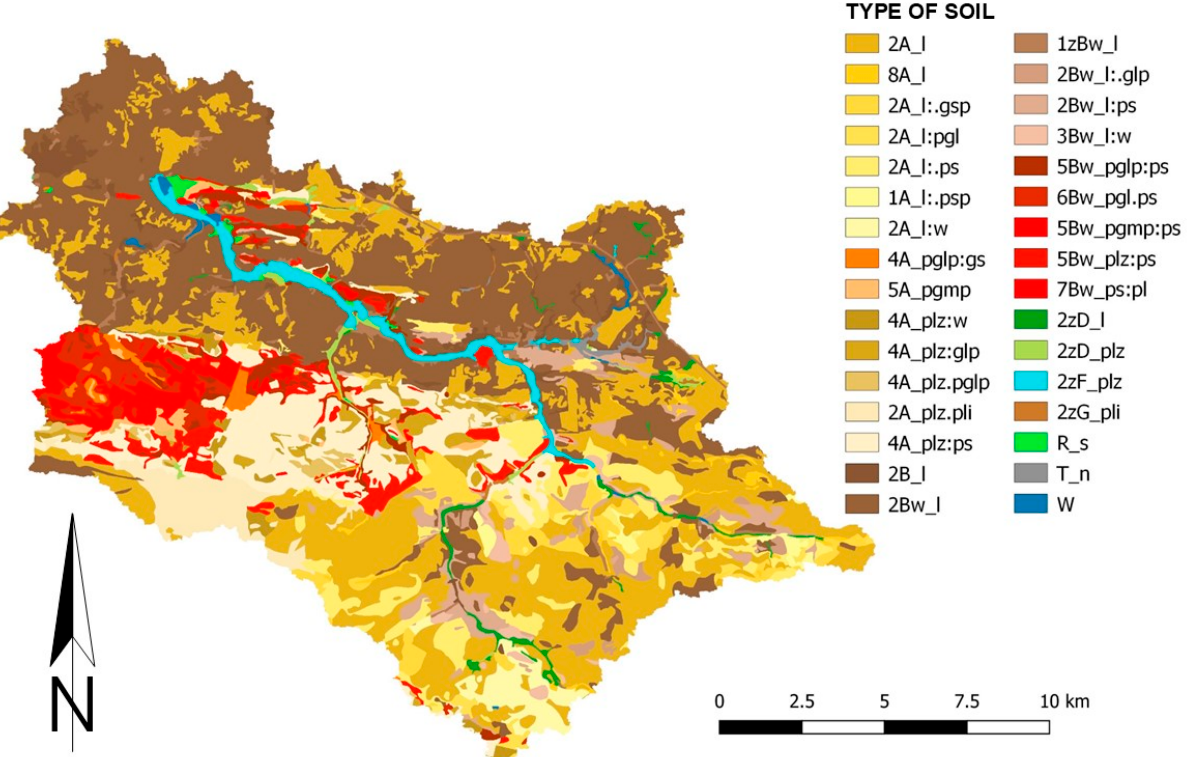
Figure 3. Soil map introduced to the SWAT model with division into soil types (own study). Table 1. Division into soil types and species and the percentage share of soils in the Bystra basin generated in the QSWAT interface (own study).